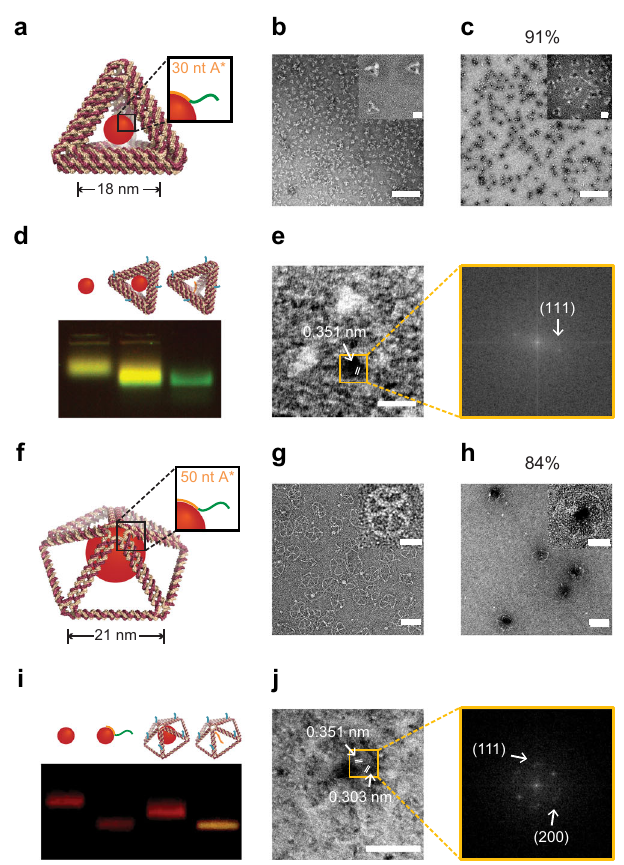
Fig. 4 | Valence-geocoded QD using tetrahedron (Tet)-QD600 and pentagonal pyramid (Pep)-QD660 assemblies. a Schematic of Tet-QD600 with 52bp edges (~18nm). Representative TEM images and HRTEM (inset) of b Tet wireframe DNA origami objects and c Tet-QD600. d AGE (0.8%) image of QD600 alone, Tet- QD600,andTetwireframeDNAorigamiobjectsalone(yellowsignal:QD600;green signal:QD600andTetwireframeDNAorigamiobjects). e HRTEMandselected-area FFT pattern (orange box) of Tet-QD600. f Schematic of Pep-QD660 with 63bp edges(~21nm). Representative TEM imagesand HRTEM (inset) of g Pep wireframe DNA origami objects and h Pep-QD660. i AGE (0.8%) image of QD660 alone, QD660 wrapped with 50ntA*, Pep-QD660, and Pep wireframe DNA origami objects alone (red signal: QD660; orange signal: Pep wireframe DNA origami objects). j HRTEM and selected-area FFT pattern (orange box) of Pep-QD660. The latticefringeswithd-spacingof0.351nmand0.303nmcanbeassignedtothe(111) and(200)latticeplanesofthecubiczincblendeCdSe.Scalebars:200nm for b – c ; 50nm for g – h ; 20nm for b inset, c inset, g inset, h inset and j ; 10nm for e . Source data are provided as Source Data fi